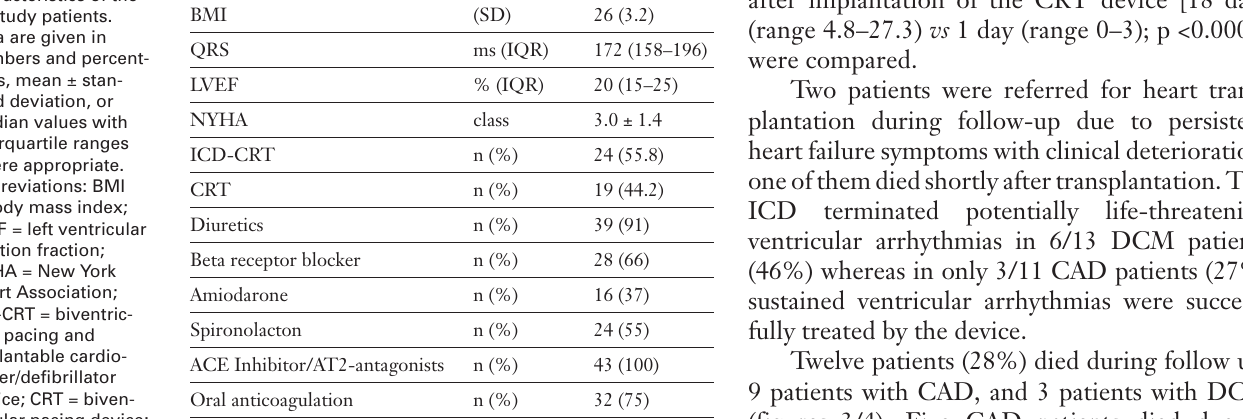
Baseline clinical characteristics of the 43 study patients. Data are given in numbers and percent- ages, mean ± stan- dard deviation, or median values with interquartile ranges where